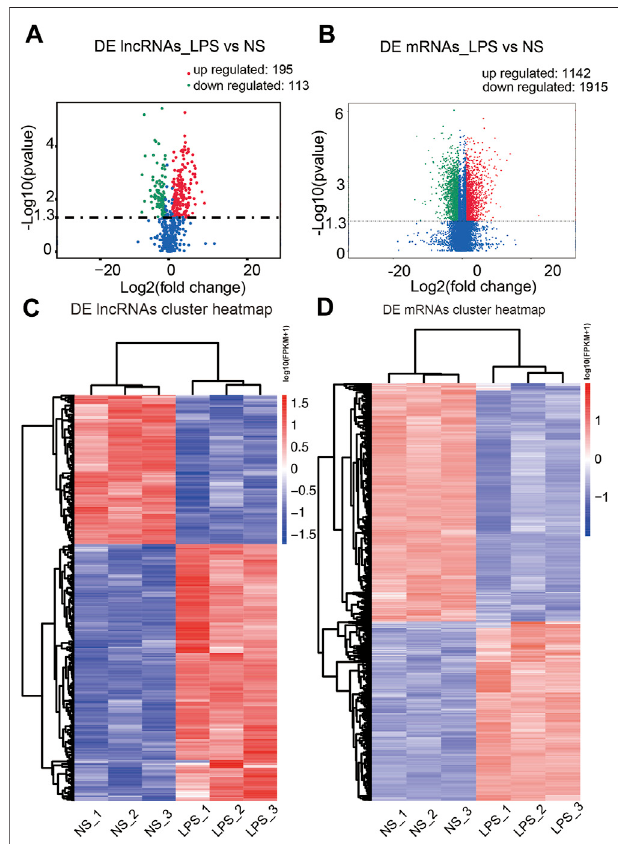
FIGURE 3 | Comparison of the levels of lncRNAs and mRNAs in mouse lung tissues. (A, B) The volcano plots presenting the uncovered DE lncRNAs along with mRNAs in lung tissue from the ALI and control groups [ p < 0.05 along with |log2 (fold change) | > 1.0]. Red designates upregulated genes, while green designates downregulated genes. (C, D) Hierarchical cluster analysis of the DE lncRNAs along with mRNAs in the ALI and control groups. Red, upregulated genes; blue, downregulated genes. LPS, lipopolysaccharide; NS, no lipopolysaccharide; DE, differentially